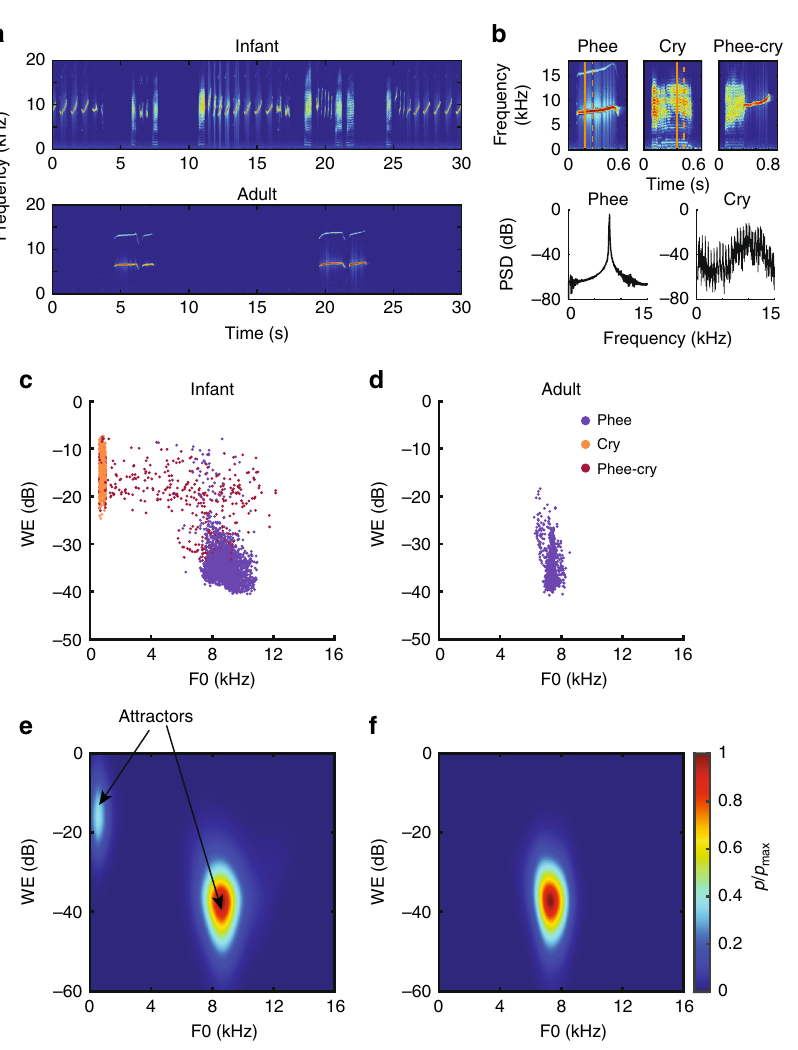
Fig. 1 Infant and adult marmoset vocalizations fall into different attractors in the acoustic space. a Spectrograms of infant (top) and adult (bottom) marmoset undirected vocalizations. b Exemplars of three different contact calls: Phee, Cry, and Phee-cry. Vertical lines in the spectrogram indicate the segment used for calculating the power spectral density (PSD) below. c , d The acoustic features of infant and adult contact calls in the Wiener entropy (WE) – f o space. e , f The max-scaled probability density of infant and adult vocal acoustic features in the WE – f o space. Source data are provided as a Source Data fi